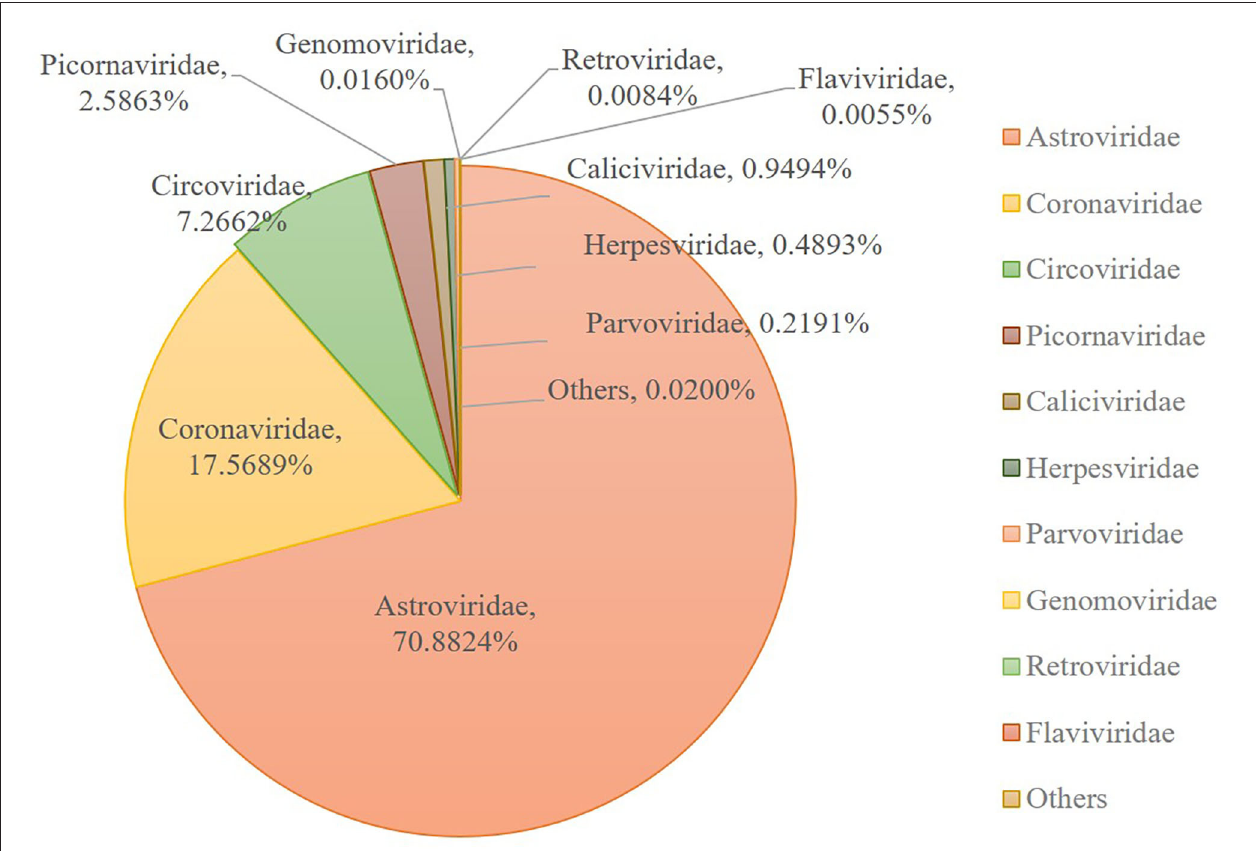
FIGURE 3 | Taxonomic distributions of the eukaryotic virus-related sequences from dog gut virome. The number of sequences with identities to eukaryotic viruses was shown.